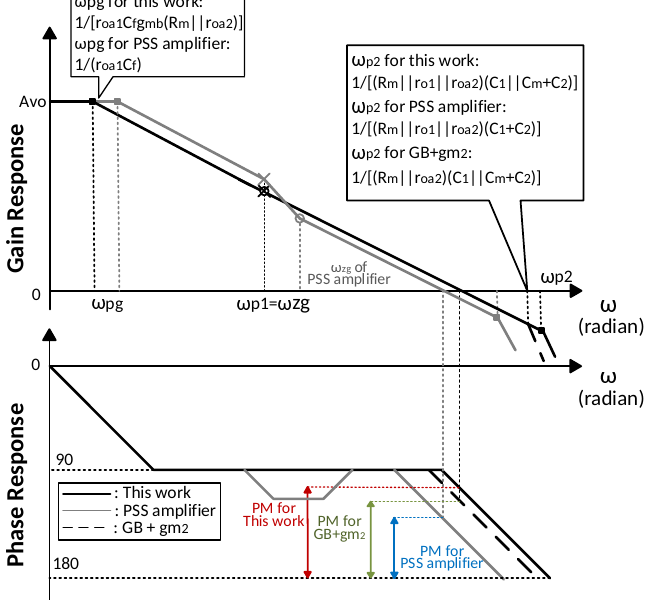
Figure 4. Frequency response for this work, the PSS amplifier [42] and the design without the first stage of main amplifier (GB+ g m2